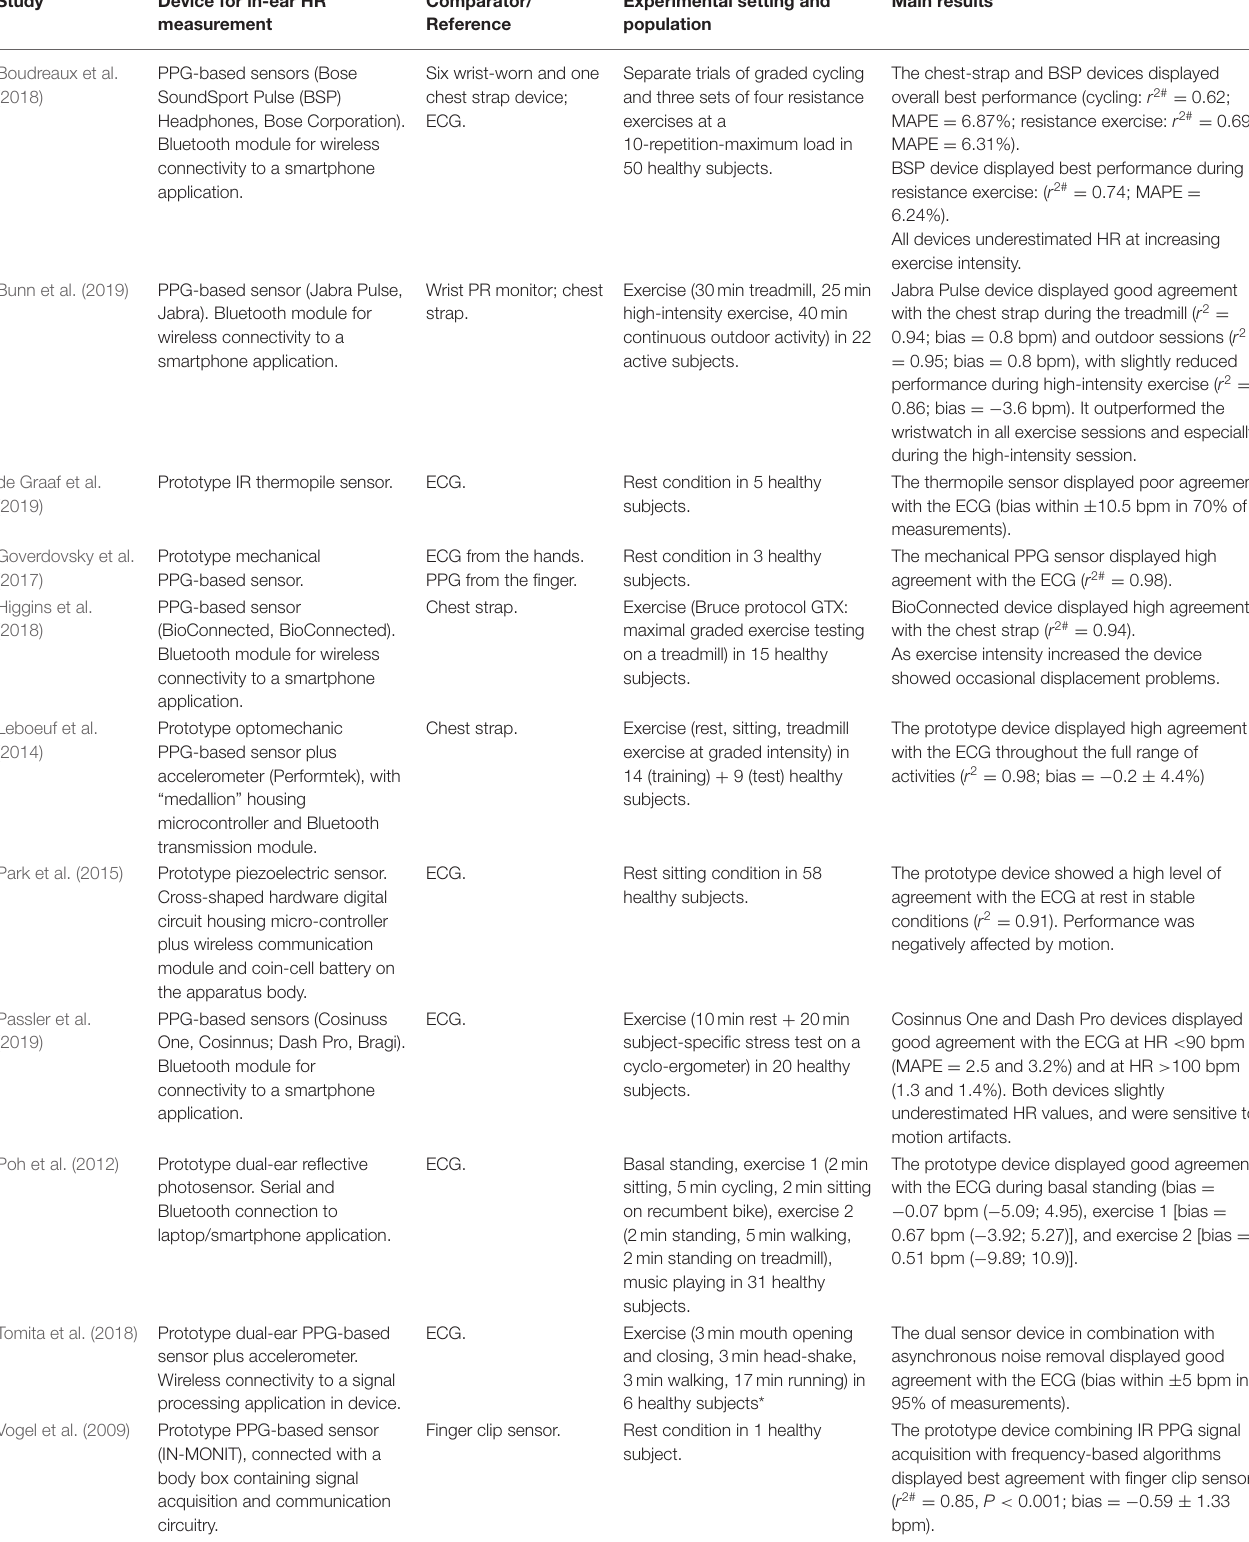
TABLE 3 | Included studies performing in-ear monitoring of heart/pulse